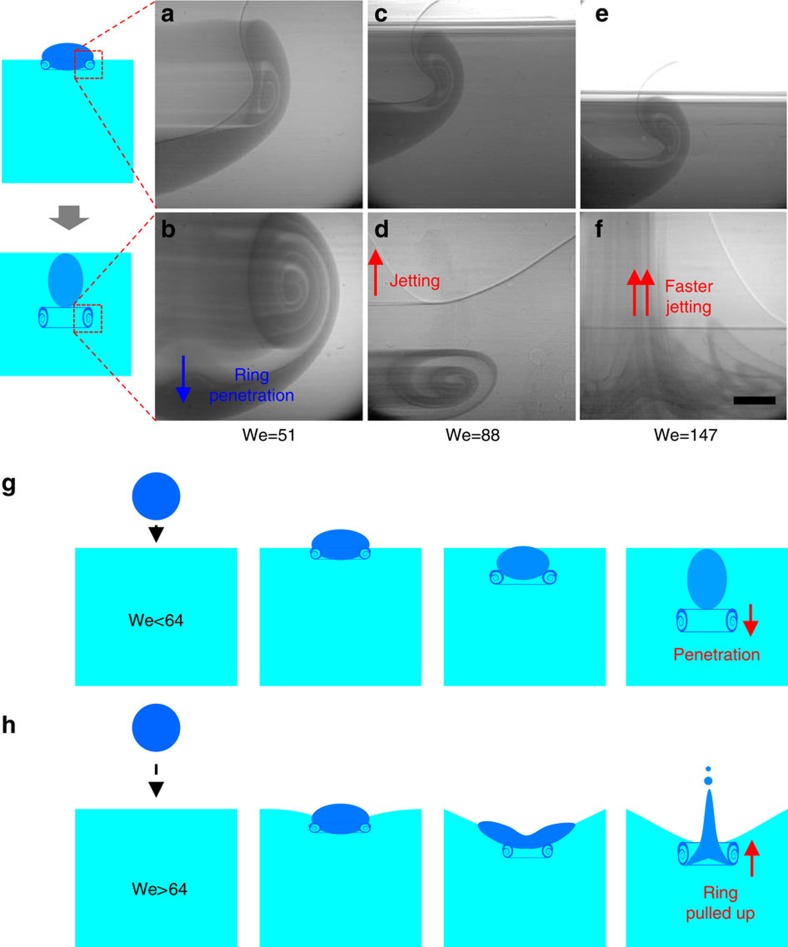
Penetration of the vortex rings.(a,b) Early (a) and late (b) stages of vortex ring formation for ethanol drop impact (with diameter ∼1.9 mm) at H=35 mm (Supplementary Movie 2). The ring penetrates the pool. (c,d) Early (c) and late (d) stages of vortex ring formation for ethanol drop impact at H=60 mm (Supplementary Movie 3). The ring is quickly pulled up with a liquid jet. (e,f) Early (e) and late (f) stages of vortex ring formation for ethanol drop impact at H=100 mm (Supplementary Movie 4). The ring is pulled up much more quickly with a stronger liquid jet. (g) Illustration of the vortex ring penetration at We <64. (h) Illustration of vortex ring pulled up with a strong liquid jet at We >64. Scale bar, 300 μm long.